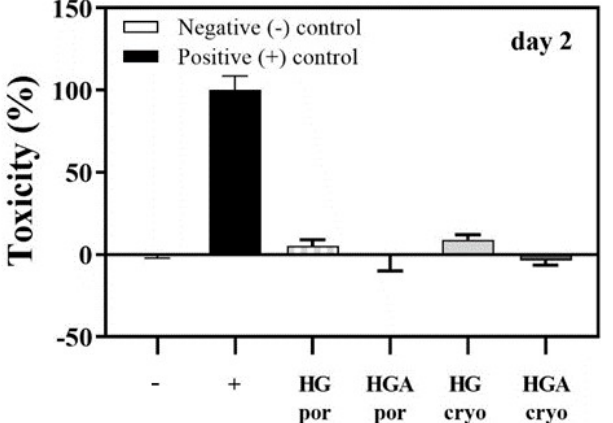
Figure 3. Cell viability based on LDH activity after 2 days of culture cells on HG por , HGA por , HG cryo , or HGA cryo hydrogel scaffolds. Negative control (0% cell death), positive control (100% cell death). Values represent the mean ± SD.